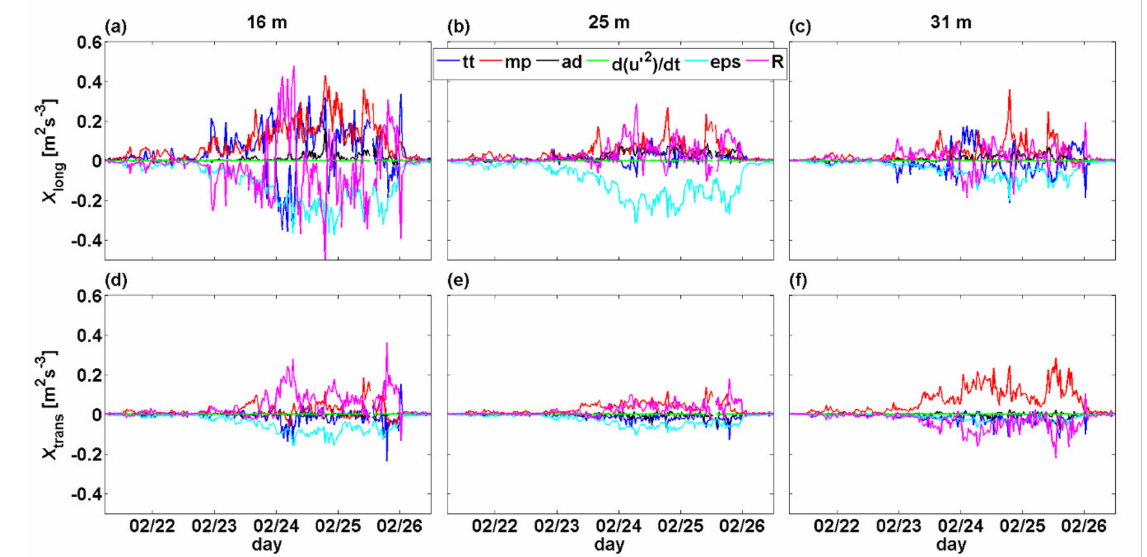
Figure 6. Time series of all the terms in Equation (2) at all three mid − levels: ( a , d ) 16 m, ( b , e ) 25 m, ( c , f ) 31 m for the longest bora episode. For every mid − level, the upper subplot ( a – c ) shows longitudinal and the lower ( d – f ) transversal terms. The terms are marked as follows: turbulence transport—black, mechanical production—red, advection of the variance by the mean wind—dark blue, local rate of change of the variance—green, VD—light blue, and the residual